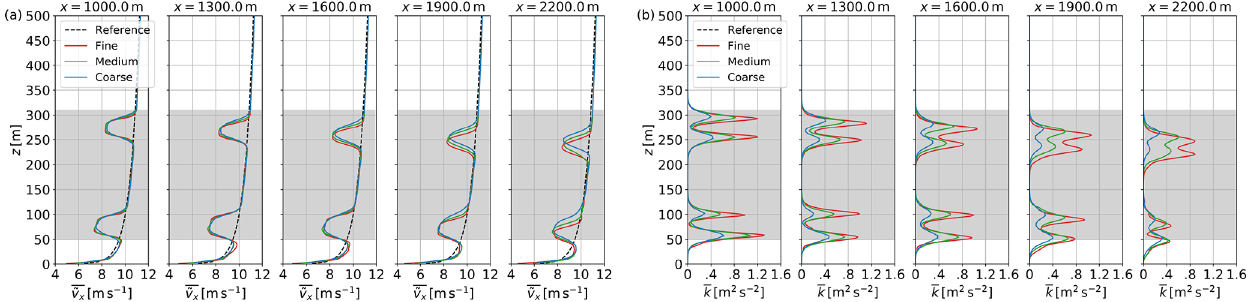
Figure A6. Time-averaged vertical profiles of streamwise wind velocity (cid:101) v x (a) and turbulent kinetic energy k (b) at several locations downstream in the wake of the AWE system for three different grid resolutions. The black dashed lines show the inflow velocity profiles, and the grey-shaded area represents the operation region of AWE systems.